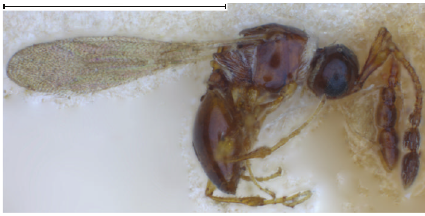
Figure 2: Doliopria collegii female in lateral view. Scale: